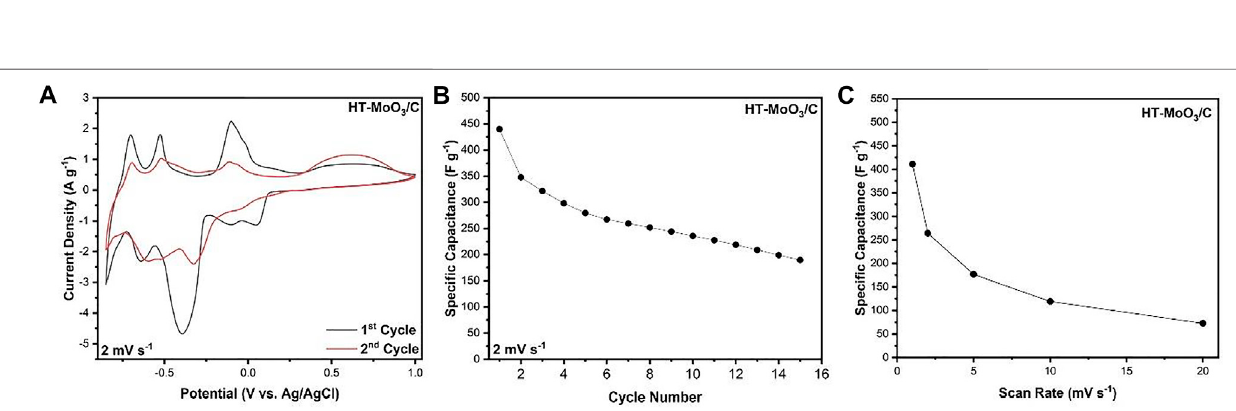
FIGURE9| ElectrochemicalchargestorageperformanceofthecellscontainingHT-MoO 3 /Celectrodesin5MZnCl 2 aqueouselectrolyteinapotentialwindowfrom − 0.85to1.00 V. (A) Firstand secondcycleCVcurvesatascanrateof2 mV s − 1 , (B) cyclingstabilityatascanrateof2 mV s − 1 ,and (C) ratecapability atincreasingscan rates (1, 2, 5, 10, and 20 mV s − 1